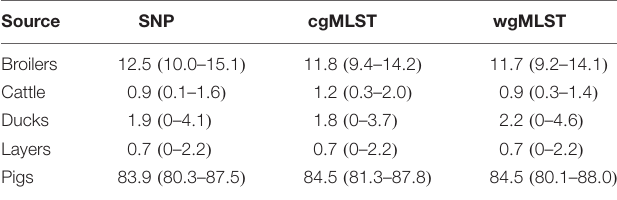
TABLE 7 | Mean probability (expressed in percentage) of a human isolate to be attributed to a source, together with confidence intervals, calculated for each of the considered pairwise distance matrices (SNP, cgMLST, and wgMLST).